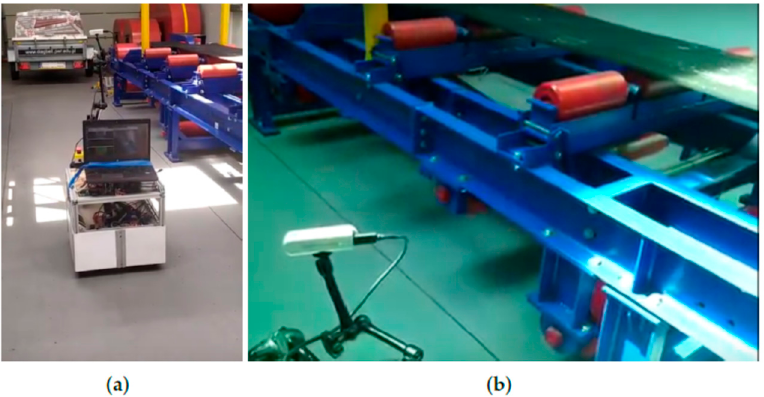
Figure 17. An inspection robot during the experiment: ( a ) general photo; ( b ) zoom on sensor (Re- printed from Ref. [109]). (Reprinted from Ref. [109]).